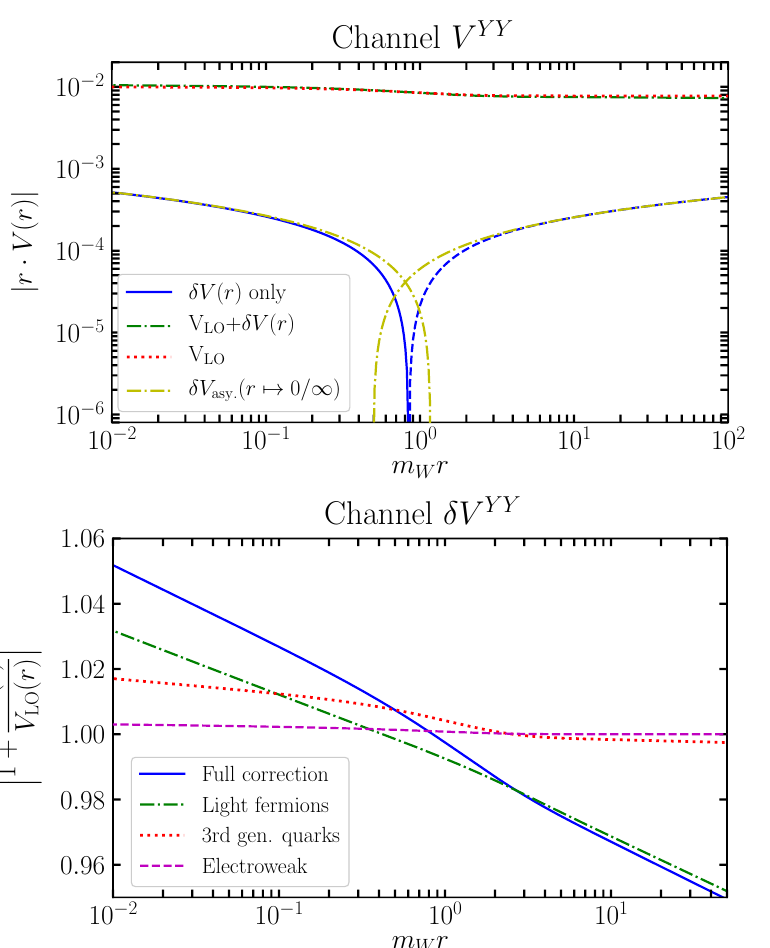
Figure 3 . The NLO correction to the tree potential V Y Y . The upper panel shows the modulus of tree the potential | r · V ( r ) | for the LO and NLO potential, the NLO contribution only, and the asymptotic behaviours (the change from solid to dashed indicates the sign change of the correction). In the lower panel, we show the ratio of the full NLO potential to the LO potential (blue solid) and separately for the three gauge invariant pieces identified in the text (other